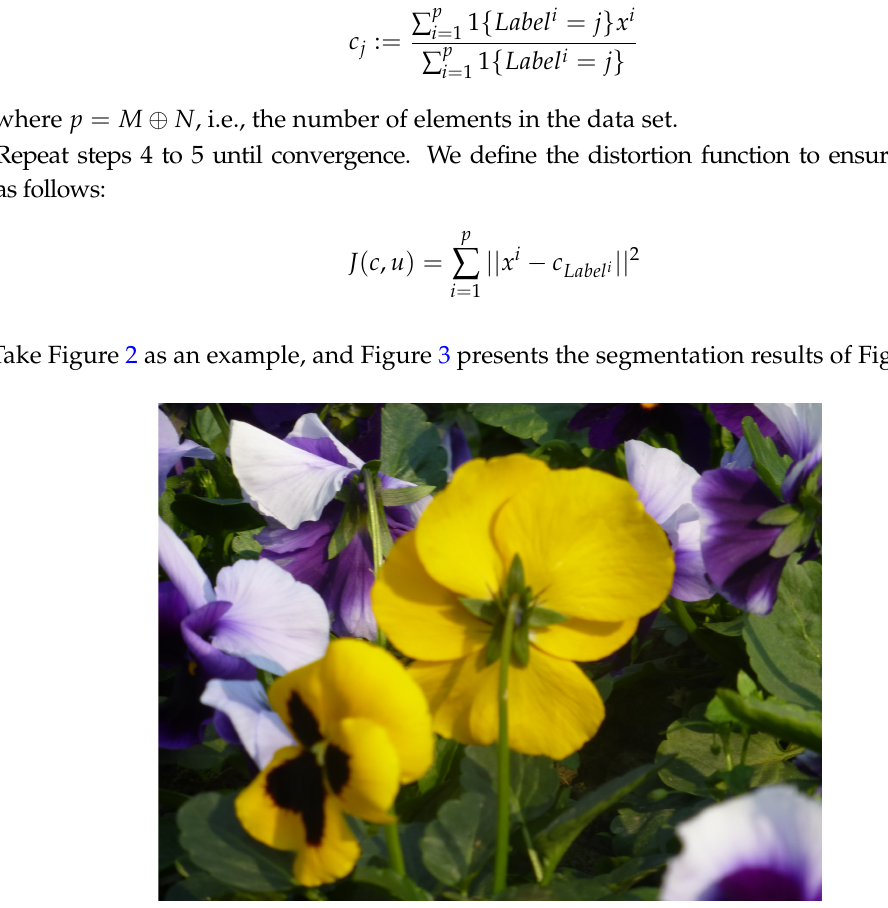
Figure 2. An original